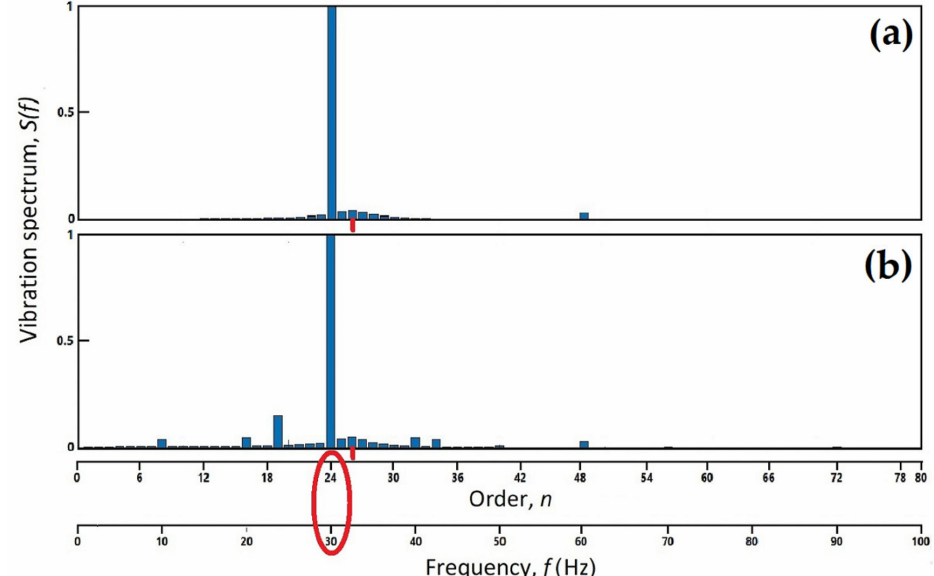
Figure A10. Idea of the spectrum of the vibration component caused by the cavitation: ( a ) cavitation as in Figure 14 but with all local patterns equal; ( b ) cavitation with a slightly disturbed set of the local patterns. Only the resonance at 32.5 Hz is considered, the damping ratio 0.05 is assumed; the amplitude scale is arbitrary. Table A1. Vibration data in four extreme cases. Number of guide vanes causing cavitation Number of runner blades with cavitation Number of cavitation events per revolution in the total intensity Vibration amplitude is proportional to thus, for V = 24, B = 4, to Basic vibration frequency = revolution frequency multiplied by thus, for V = 24, B = 4, by The danger introduced by the All/All-case and other rich configurations of cavitation events, such as in Figure 14, is evident: on a high frequency, which is close to the resonance, they generate a very high vibration